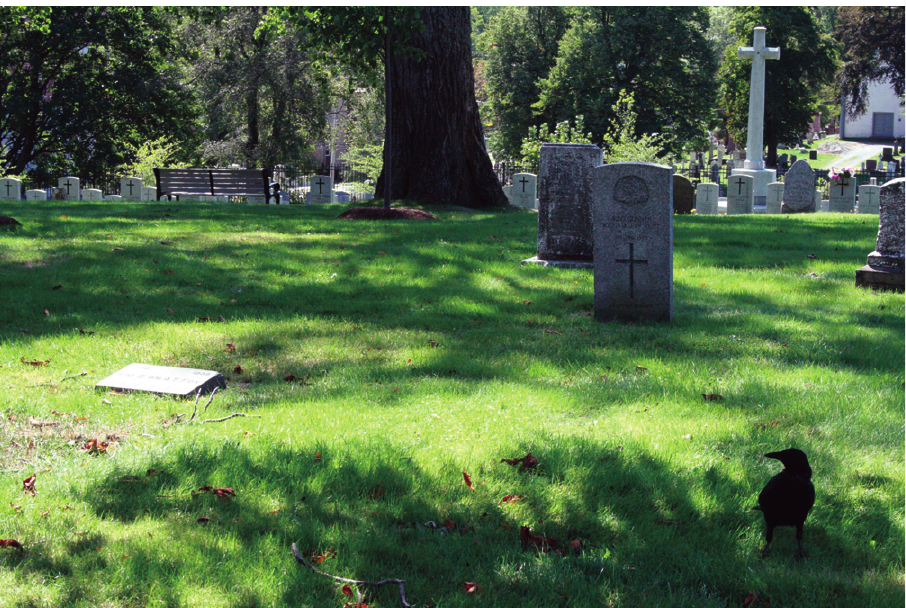
Figure 2. Photograph of the habitat at the Fort Massey site where Phosphaenus hemipterus specimens were collected. Foraging birds, such as the American Crow ( Corvus brachyrhynchos ) in the foreground, could be potential predators of diurnal beetles such as P. hemipterus. Photo credit: Christopher